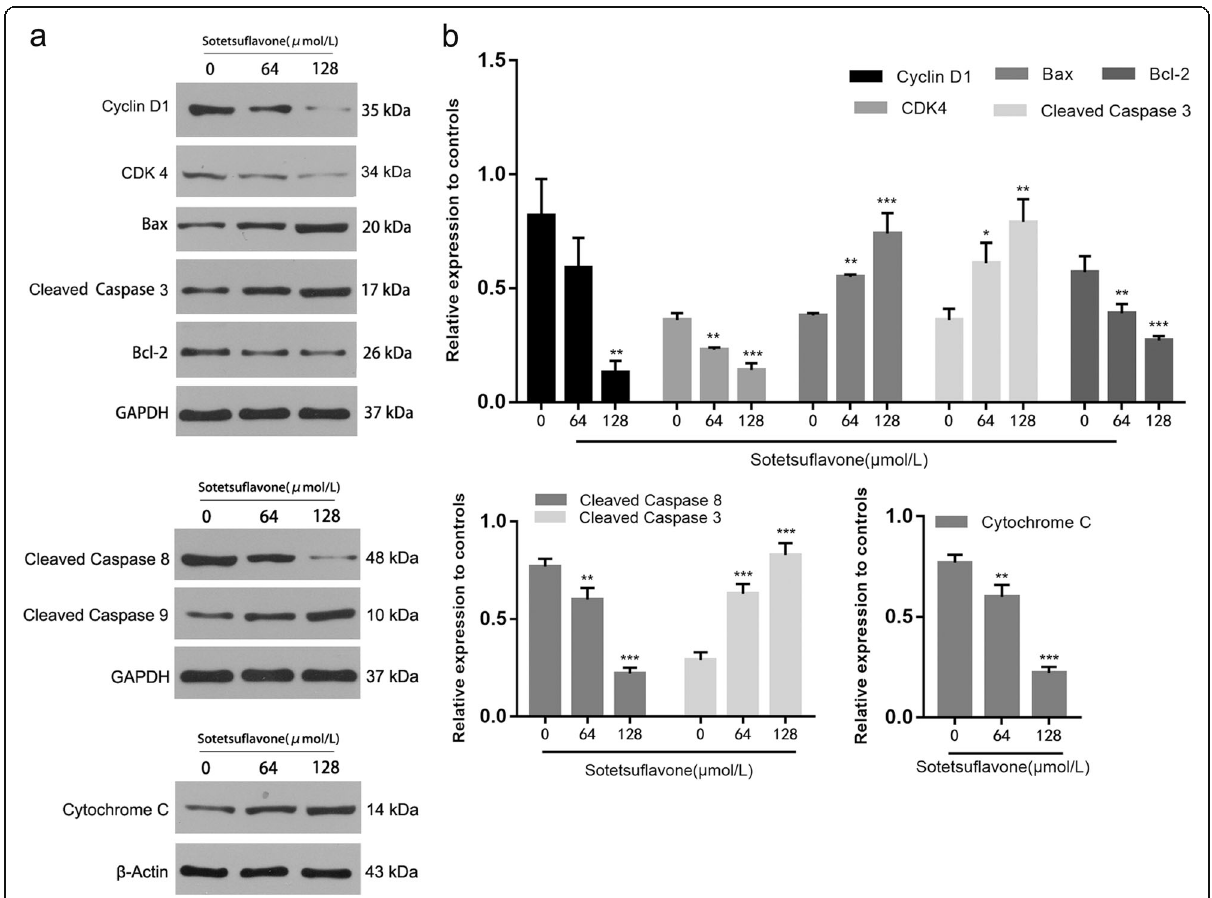
Fig. 6 Sotetsuflavone changes the expression level of apoptosis and cycle-related proteins. a the expression level of apoptosis and cycle-related proteins modulated with sotetsuflavone for 24 h, GAPDH and β -actin expression were determined to confirm equal protein loading. b The relative expression level of apoptosis and cycle-related proteins. The results from three independent experiments were expressed as mean±SD compared with the control group, * P <0.01, ** P <0.01, *** P